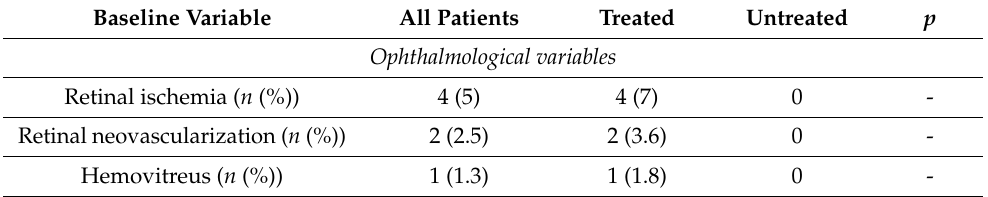
Table 2. Ophthalmological outcomes, composite endpoint components, and median survival time at the end of follow-up of patients treated and untreated with antithrombotic